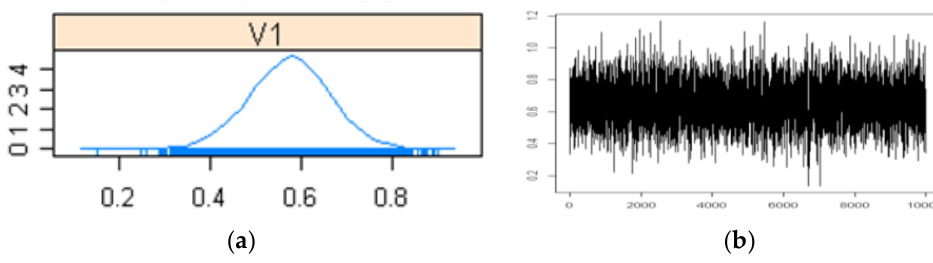
Figure 11. ( a ) Density and ( b ) trace plot of β 0 (case study). The density plot for (cid:2028) (cid:2870) is given in Figure 12a, which shows that the marginal pos- terior distribution of (cid:2028) (cid:2870) is skewed to the right. The trace plot of (cid:2028) (cid:2870) in Figure 12b shows that the chains have slowly converged.